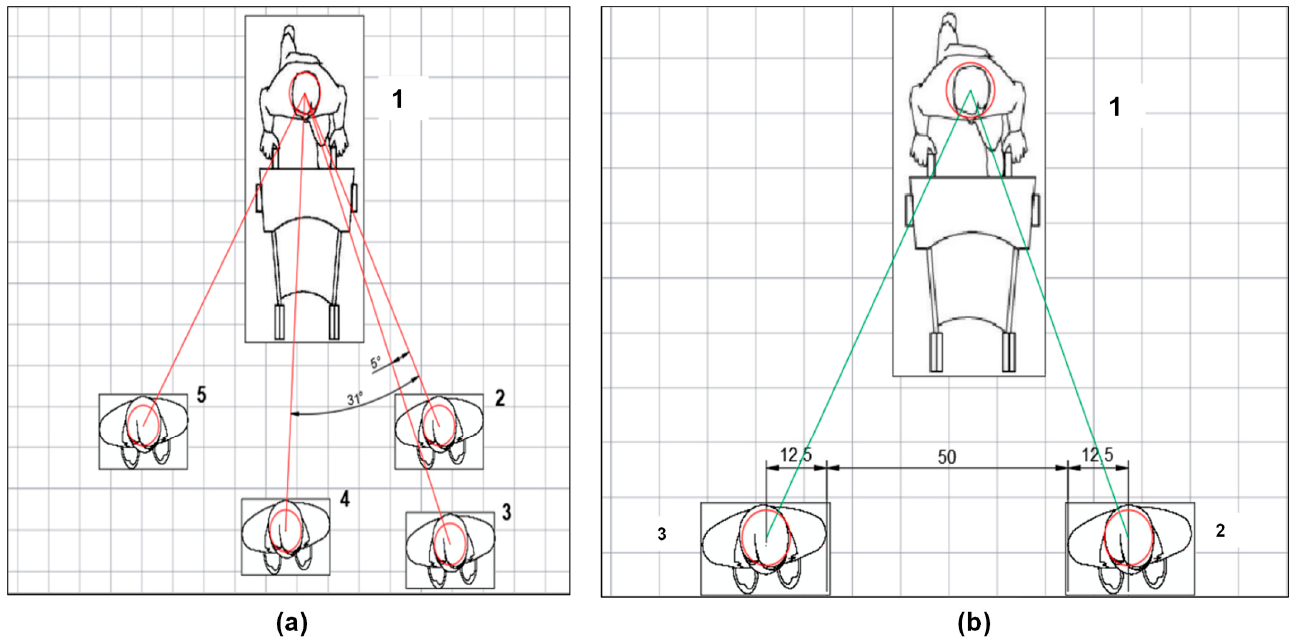
Figure 2. Criteria a passenger with the reduced mobility (labeled as passenger N ◦ 1) and those passengers around him/her (labeled as passengers N ◦ 2 to N ◦ 5): ( a ) according to the angle between them; ( b ) regarding the distance (in cm) between them.